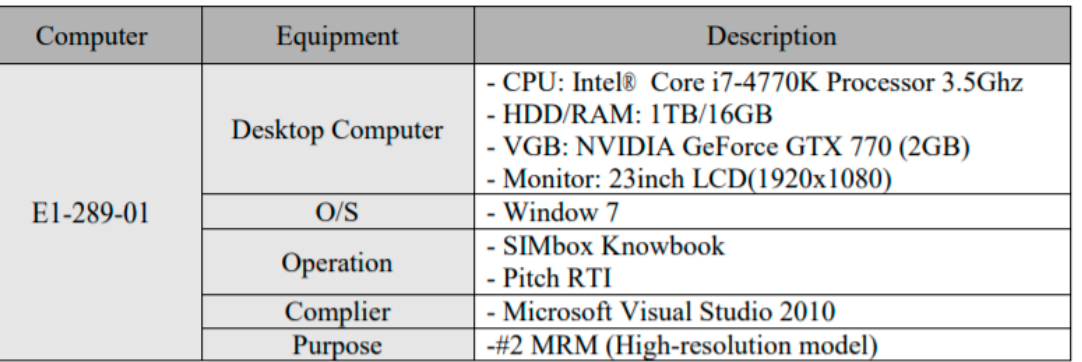
Figure 11. Operation environment for MRM (low-resolution simulation).